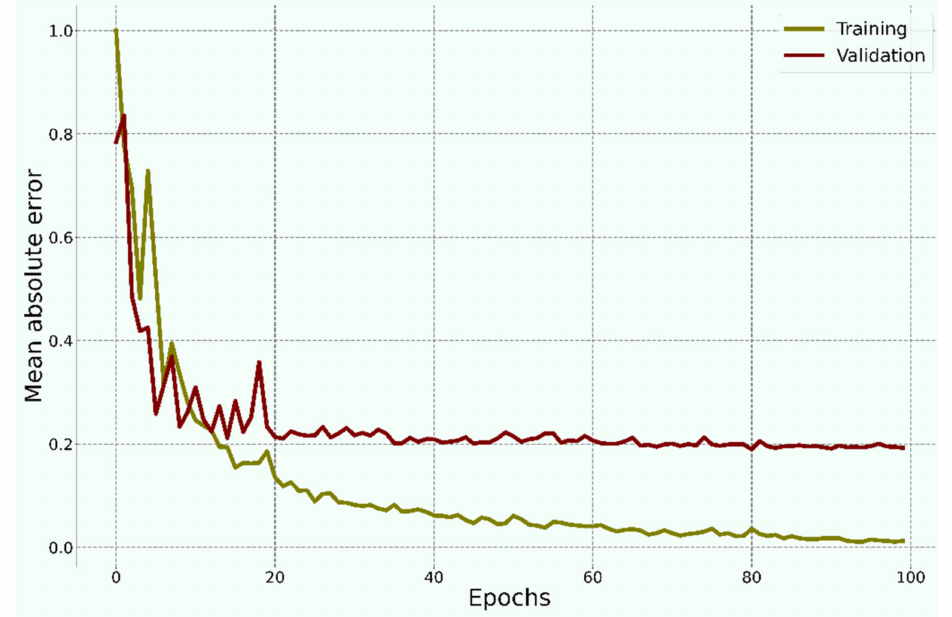
Figure 5. The MAE values for training and validation datasets.